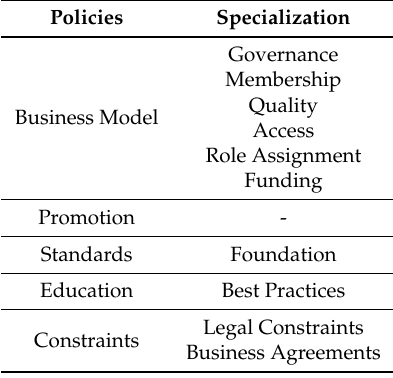
Table 1. Unification of the policies by the ICA and from the extension by Béjar et al. [4]. Source: